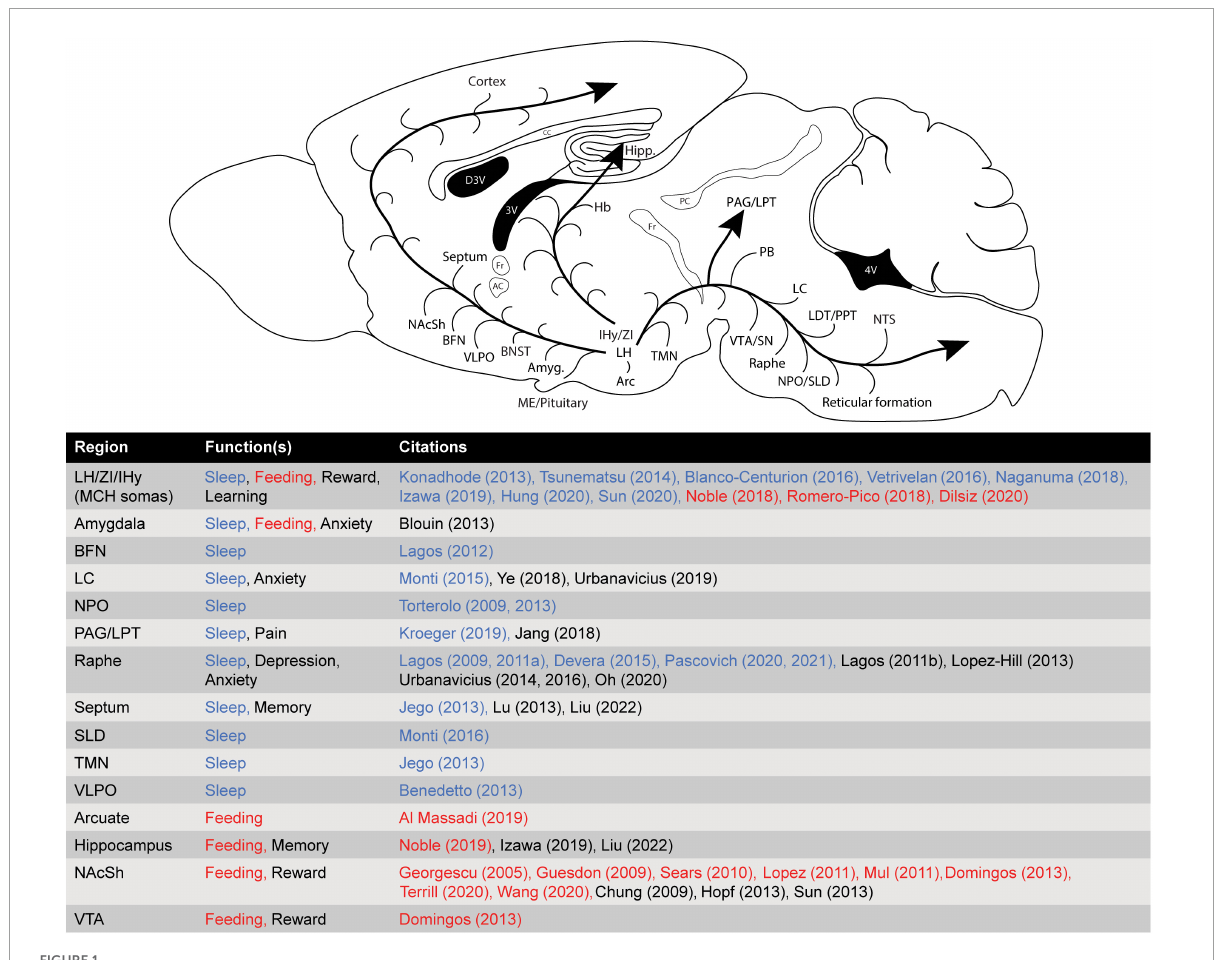
FIGURE1 Major brain regions receiving significant innervation from the MCH system, and their corresponding behavioral